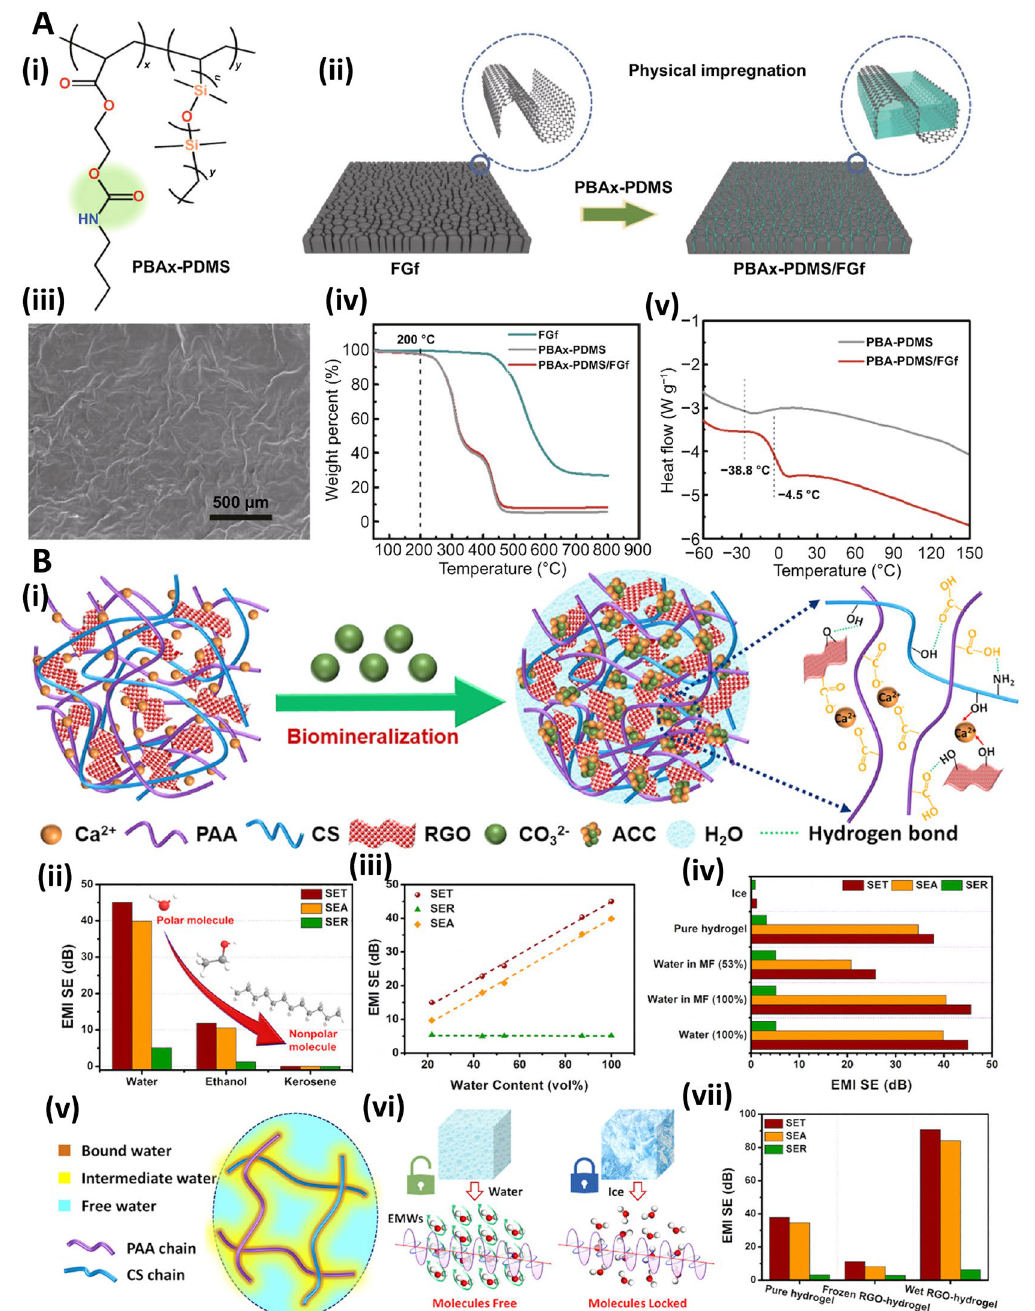
Fig. 7 (A) Structure of PBAx-PDMS ( i ). Preparative process of PBAx-PDMS/FGf ( ii ), and the morphology of the introduced nanocomposite ( iii ). Thermogravimetric analysis plots of PBAx-PDMS and PBAx-PDMS/FGf ( iv) . Differential scanning calorimetry curves of PBA-PDMS and PBA-PDMS/FGf (v) . Reproduced with permission from Ref. [86]. Copyright 2022 Springer Nature. (B) Synthesis of rGO composite hydrogel (i). EMI shielding efficiency (SE) variation with molecule polarity (ii). Difference of the EMI SE of H2O2 with the volume content in melamine foam (MF) (iii). Assessment of the EMI SE of water without MF, with MF, and the hydrogel (iv). The three different water types in the hydrogel (v), electromagnetic waves (EMW) transfer crossways water and ice (vi). The activity of the pure hydrogel along with the frozen and wet RGO- hydrogels (vii). PBA: 2-[[(butylamino)carbonyl]oxy]ethyl ester; PDMS: polydimethylsiloxane; FGf: folded graphene film; ACC: amorphous cal- cium carbonate; PAA: poly(acrylic acid); CS: chitosan. Reproduced with permission from Ref. [21]. Copyright 2021